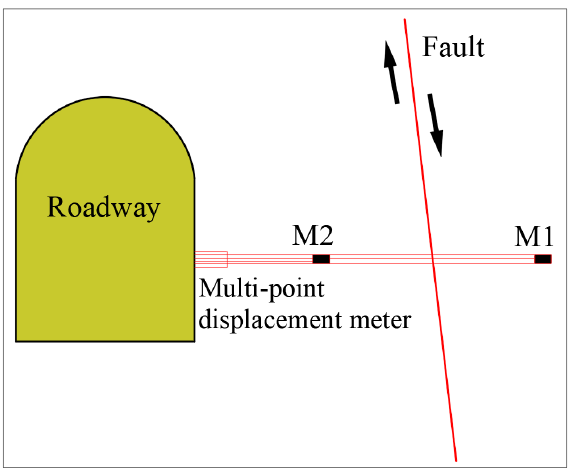
Figure 4. Installation diagram of the multipoint displacement meter.